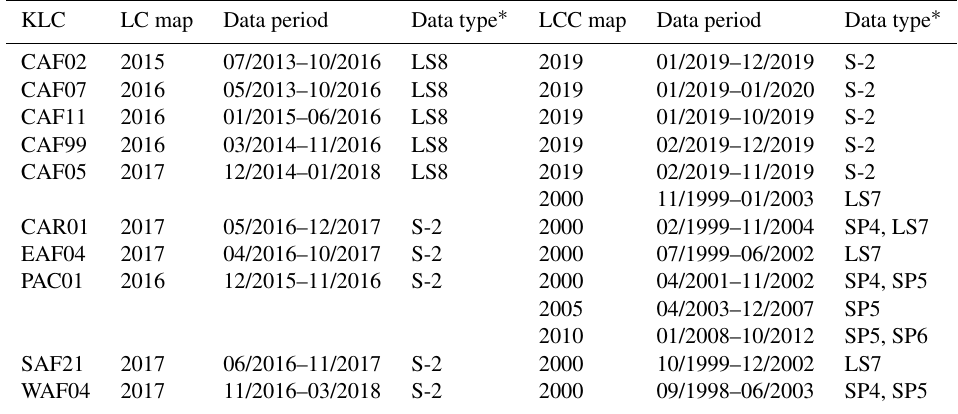
Table A1. Satellite data collecting period and type used for LC and LCC mapping. Date format is month/year.